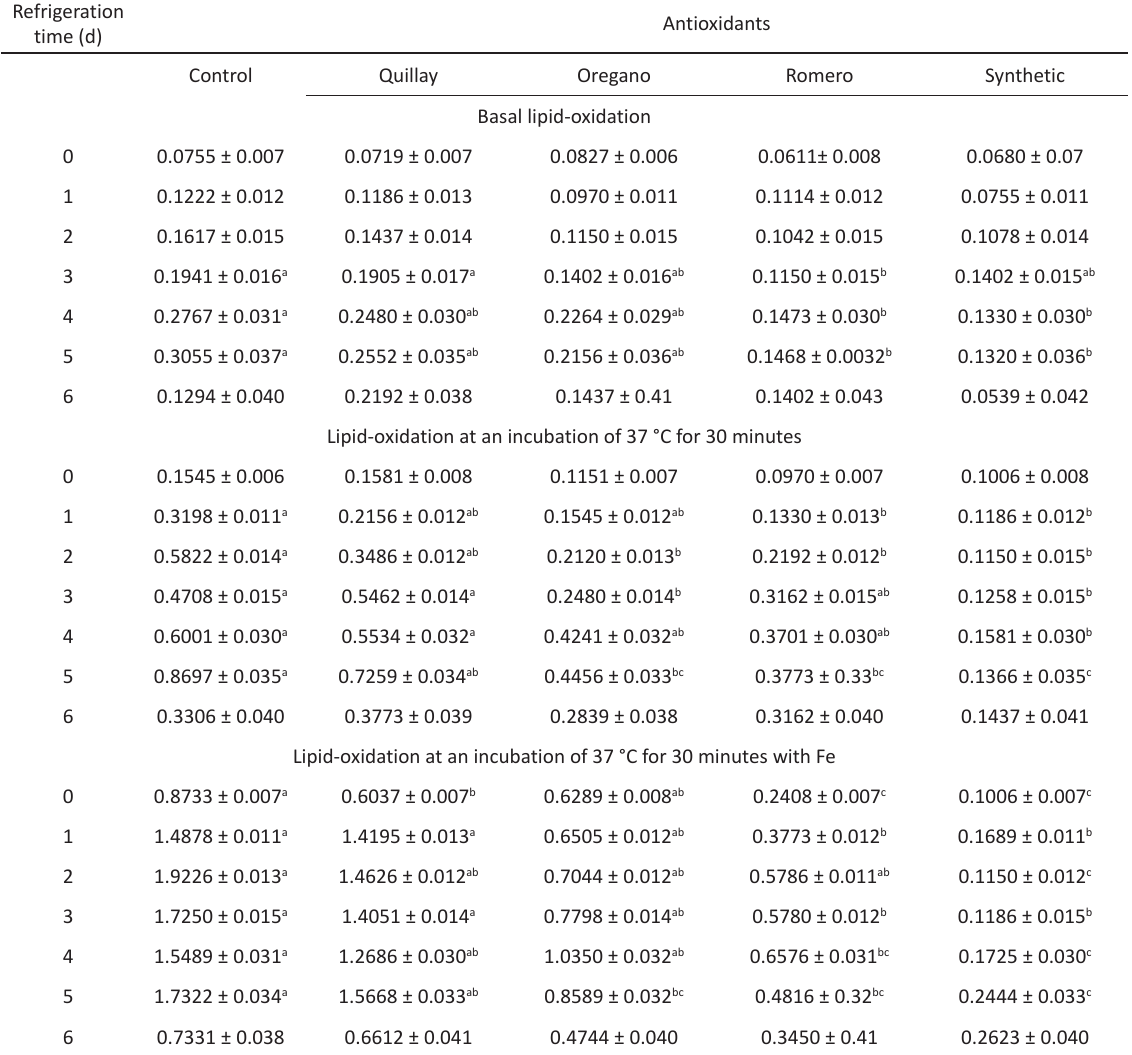
Table 2. TBARS values (µg MDA g -1 of fresh tissue), obtained with equivalent dose and with 4% absorption of marinating in the belly flap region (average ± standard error of the